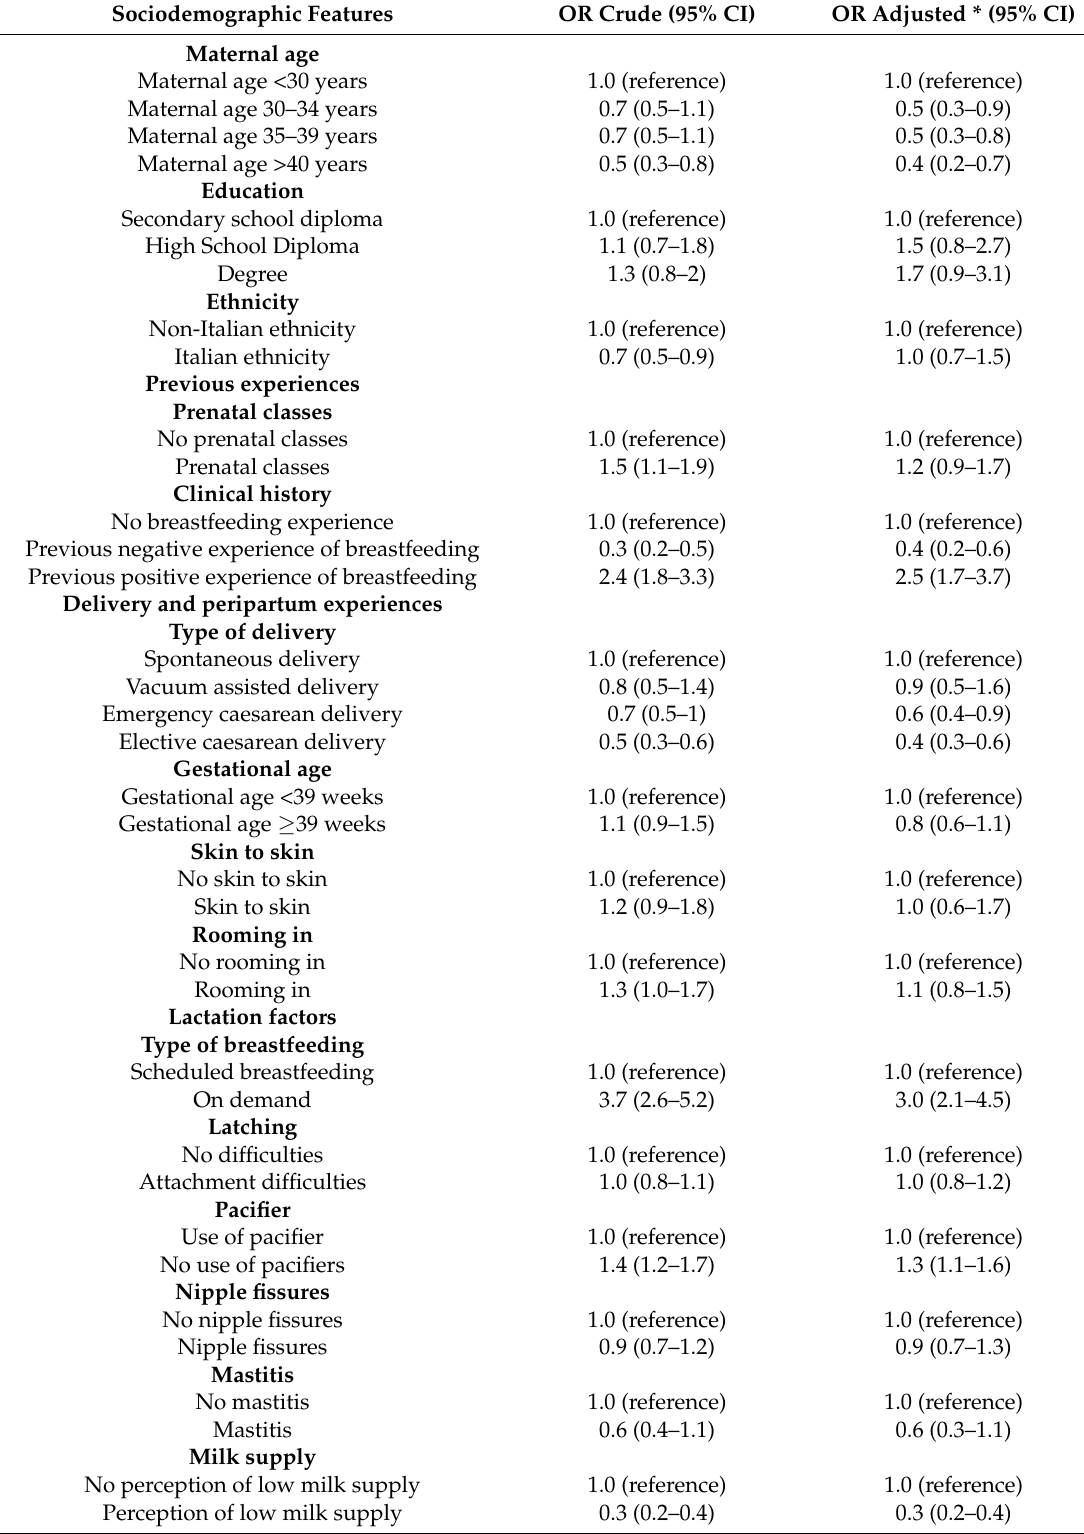
Table 3. Factors affecting breastfeeding: results of univariate and multivariate logistic regressions. Sociodemographic